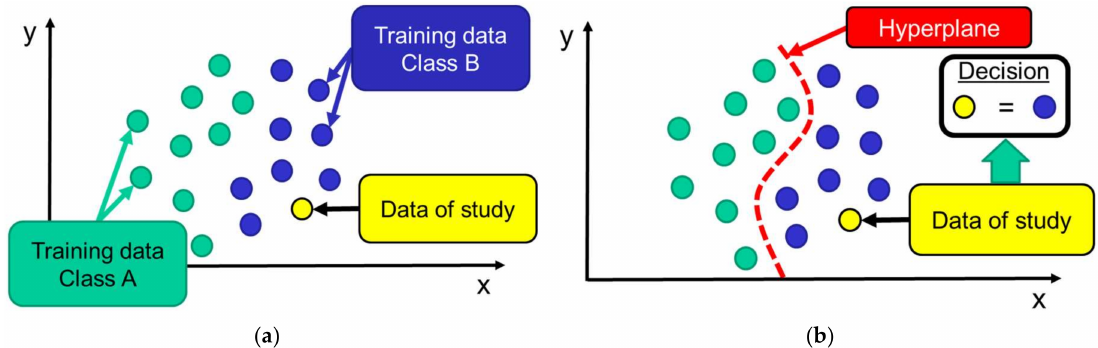
Figure 5. Example of the performance of the SVM algorithm for a two-dimensional space (samples characterized by two input features): ( a ) distribution of the training data on the two-dimensional space ( b ) creation of the hyperplane and classification decision for a certain test data.